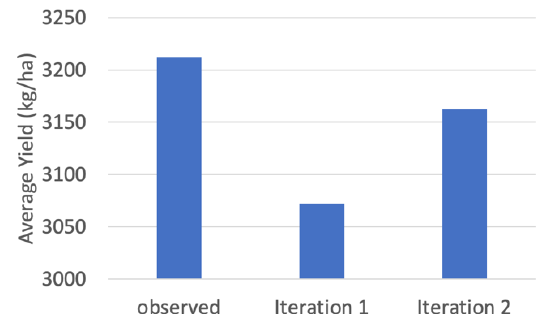
Figure 6. Average yield values of all the fields derived from iterations 1 and 2 and the ground